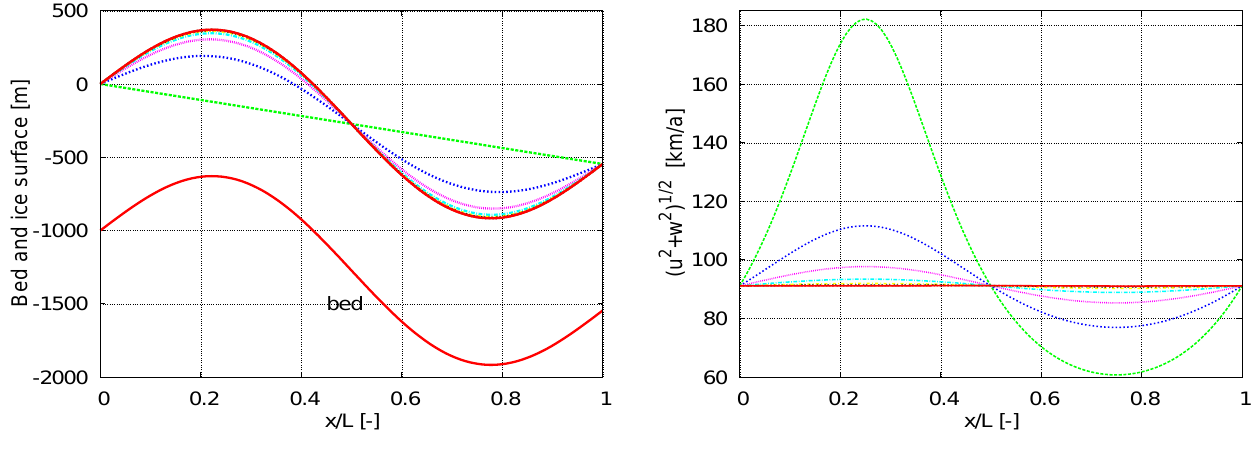
Fig. 2. 2-D flowline time dependent experiment – ice stream flow over bumpy bed; the steady bed and transformation over time of the ice surface (left) and transformation over time of the norm of the surface velocity (right). Ice surface and the norm of the surface velocity are shown every 1.5 years over the 14-year period, green curves are the initial values and red curves are the final